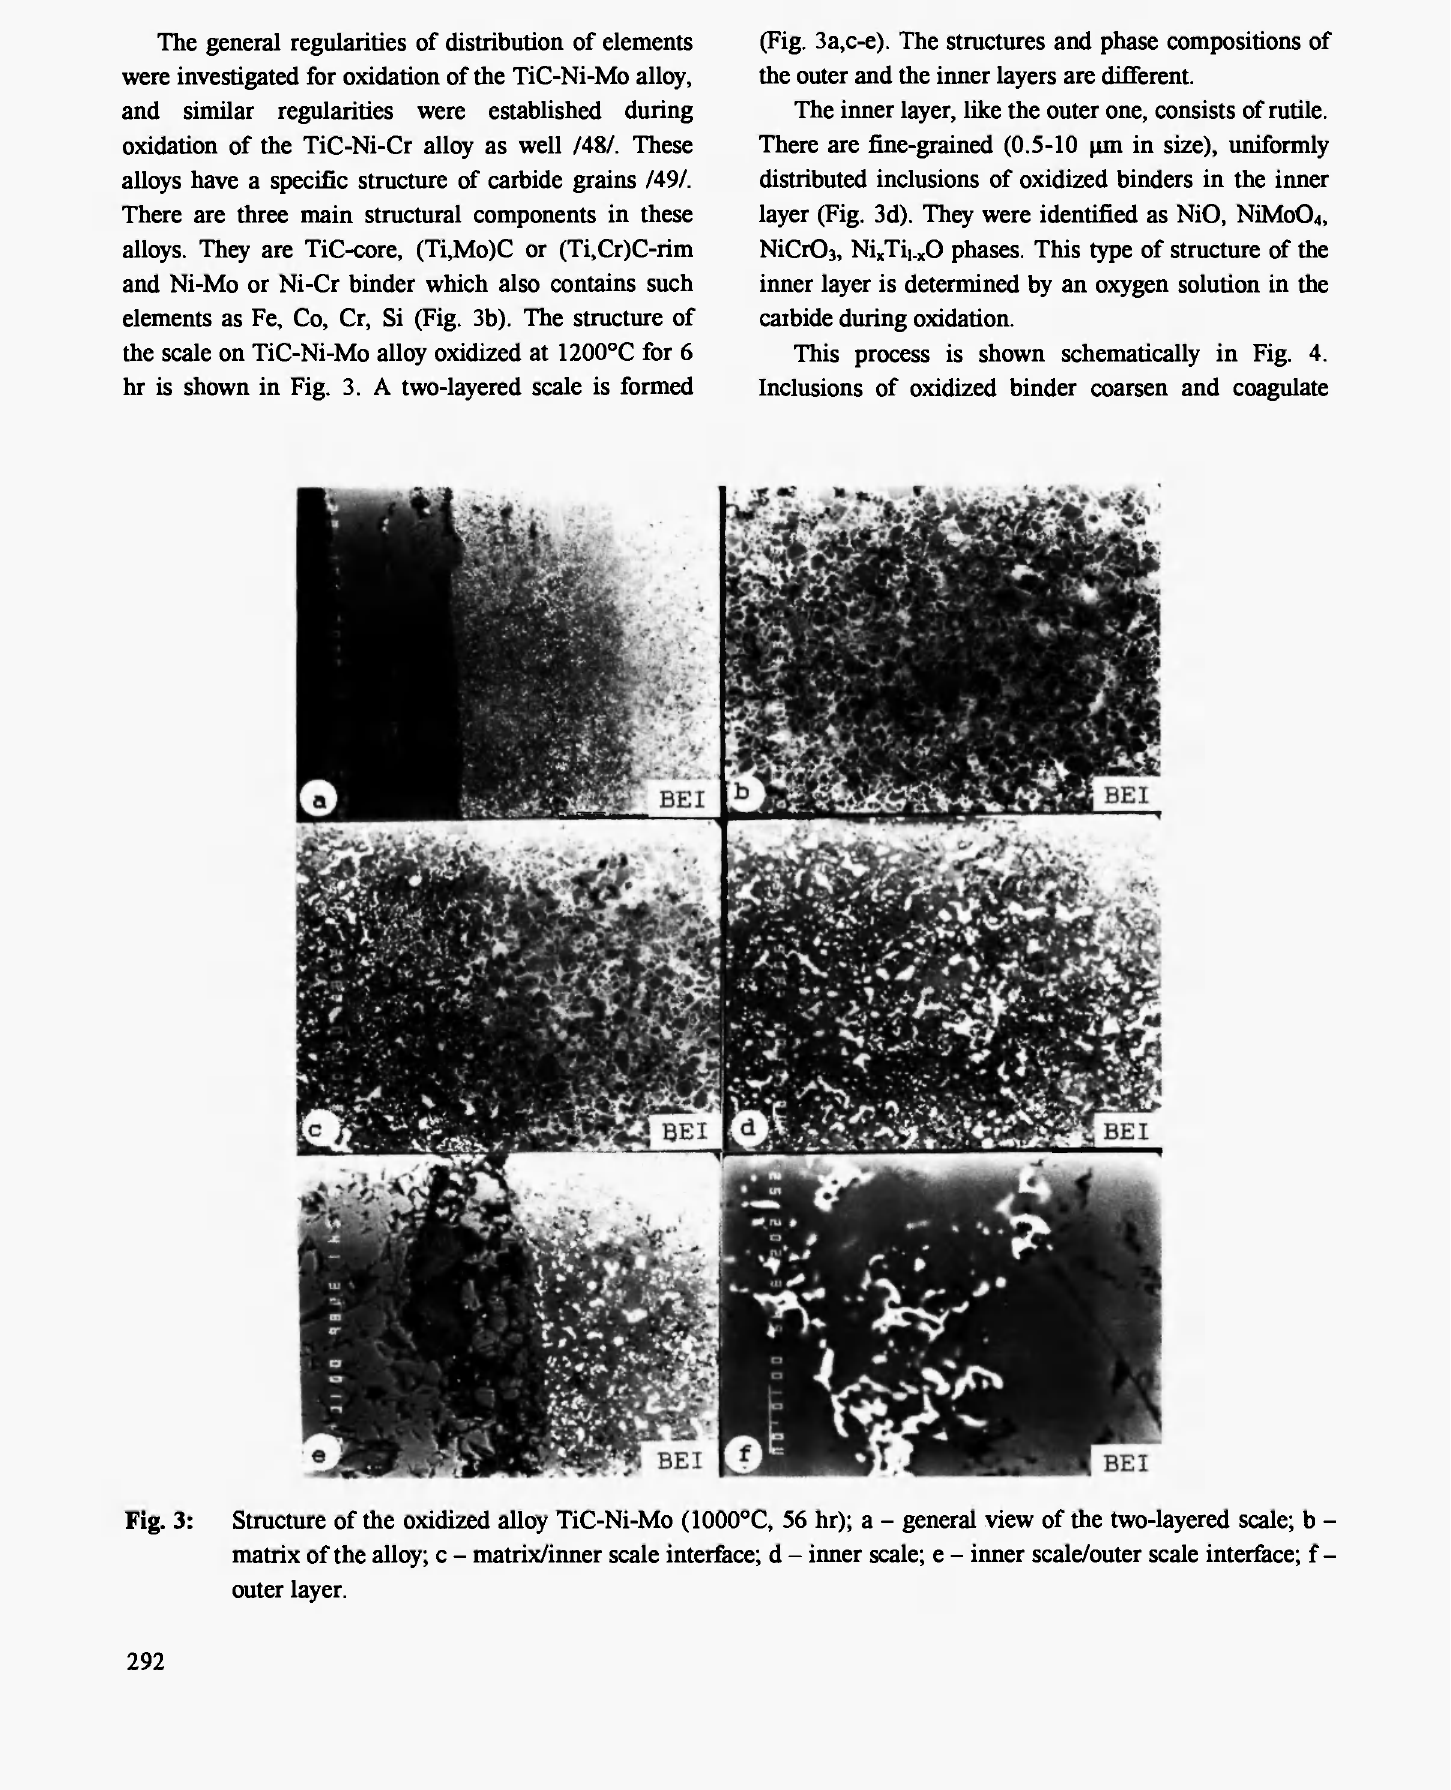
(Fig. 3a,c-e). The structures and phase compositions of the outer and the inner layers are different.